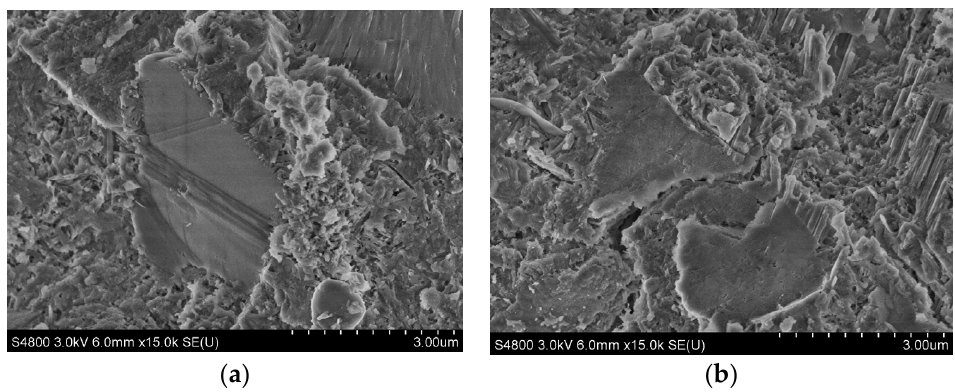
Figure 6. Microstructure of the C30 concrete at different sulfate attack ages. ( a ) 60 d; ( b ) 360 d.